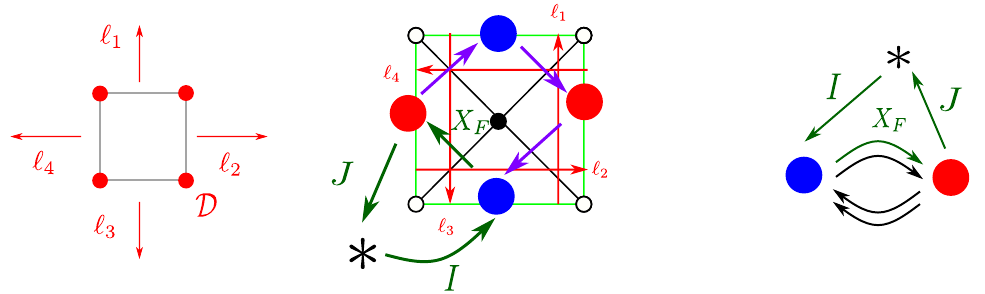
Figure 11. Quiver of the conifold with a D4-brane wrapping the toric divisor D = p 2 . Left: the divisor is surrounded by external legs ‘ . Middle: the flavor node ∗ is drawn outside the brane 2 , ‘ 3 tiling for convenience. Two arrows I, J are added to the quiver diagram. The bifundamental field X F for this case is X F = α 2 . Right: the enhanced quiver, where the green arrows introduce a new term W = Tr ( JX ) to the superpotential. flavor F I